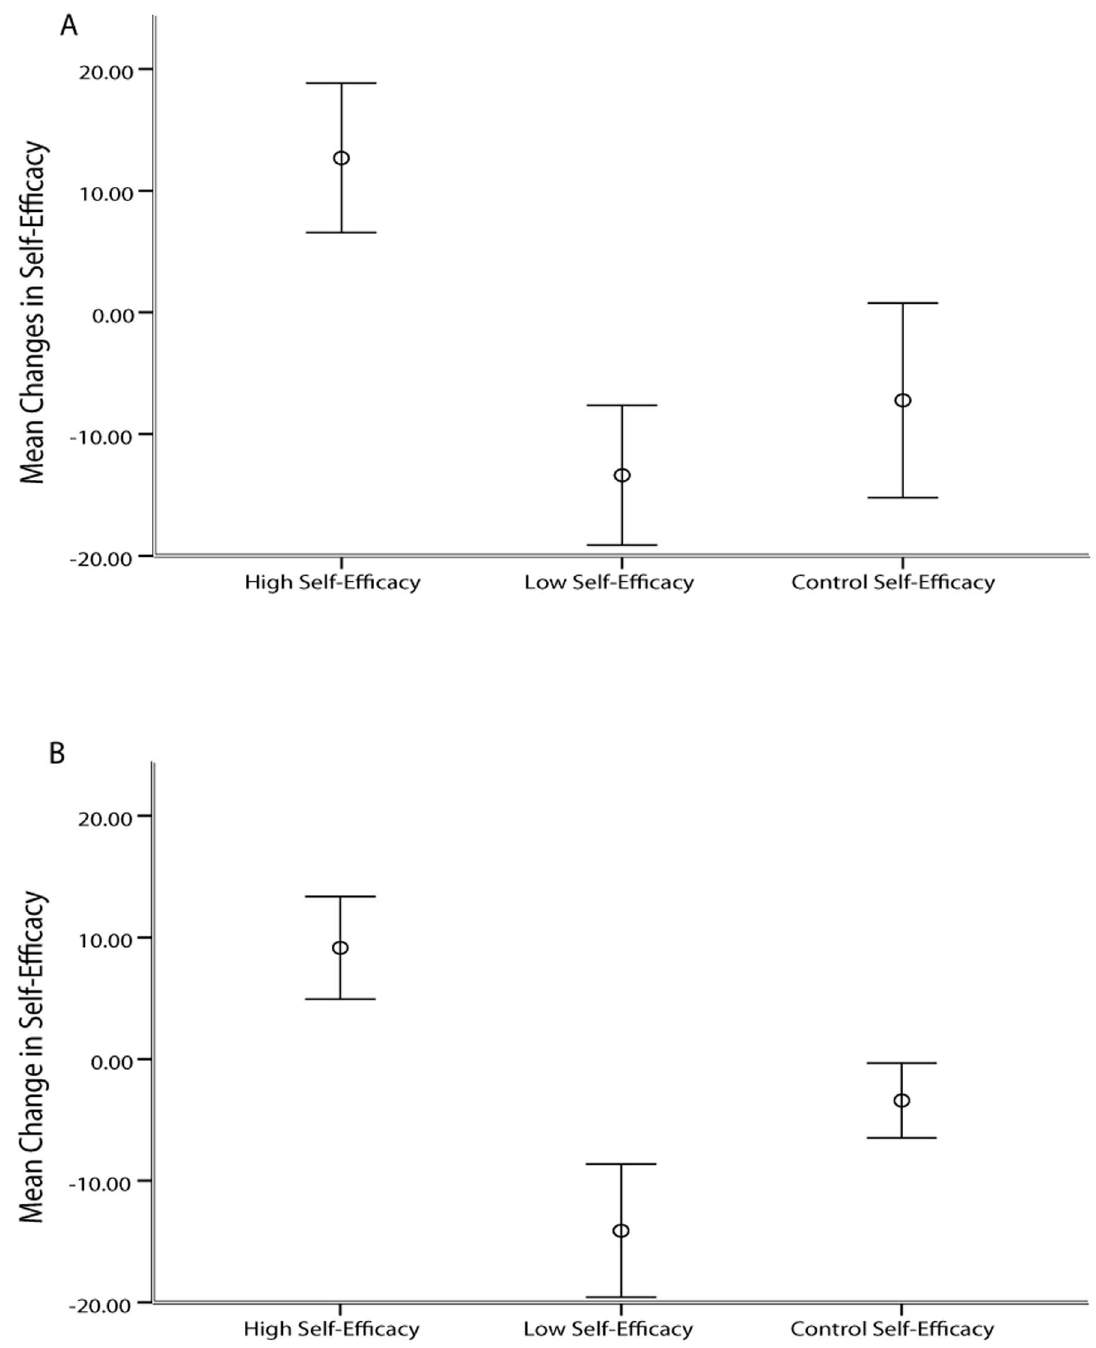
Figure 3. Magnitude of mean change in SE across groups in the A contrast and B orientation task. Error bars represent the confidence intervals surrounding the means (CI=95%). For both tasks, participants assigned in the high SE group increased while participants assigned in the low SE group decreased their SE compared to the control group.